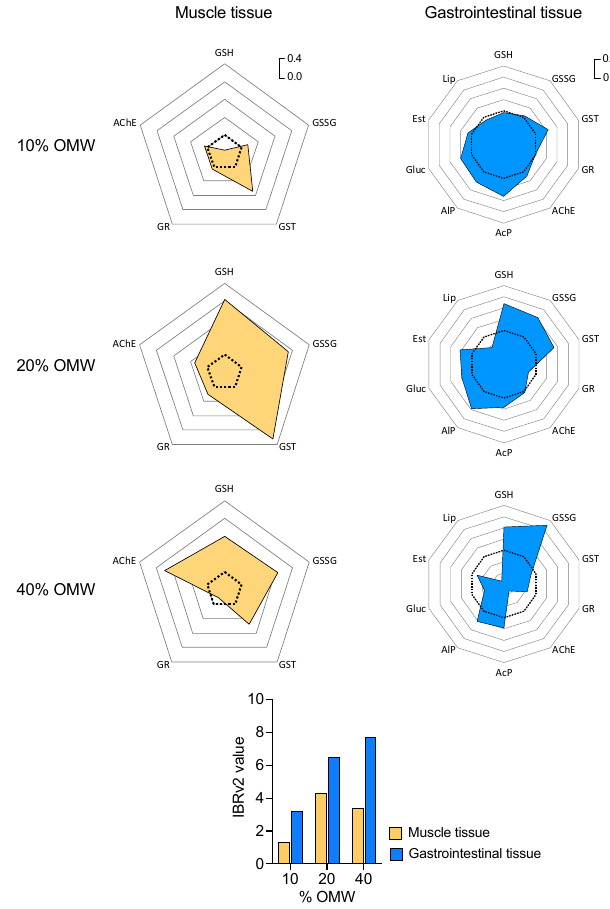
Figure 4. Sunray plots of the deviation index ( A i scores) of biomarker measured in body wall muscle and gastrointestinal tissue of Lumbricus terrestris exposed after 30 d of exposure to olive mill waste (OMW)-amended soils. Dotted lines in sunray plots indicate the reference values (see Materials and Methods for details). Bar plot shows the integrated biomarker response index (IBRv2) values calculated for each treatment and tissue. AChE = acetylcholinesterase, GSH = reduced glutathione, GSSG = oxidized glutathione, GST = glutathione S-transferase, GR = glutathione reductase, AcP = acid phosphatase, AlP = alkaline phosphatase, Gluc = β -glucosidase, Est =